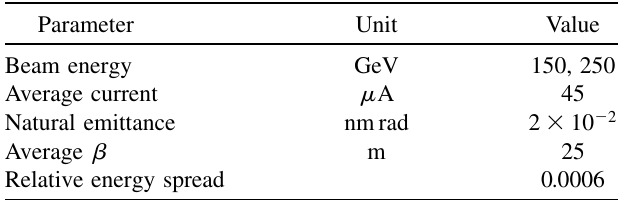
TABLE III. ILC beam parameters used for flux and polariza- tion calculation.